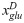
Model. IID1s. Short-term synaptic depression.A: field potential. B: short-term synaptic depression variables xgluD and xGABAD. C: the membrane current at Vh = −27mV in a representative excitatory neuron. The simulation corresponds to that in Fig 5.